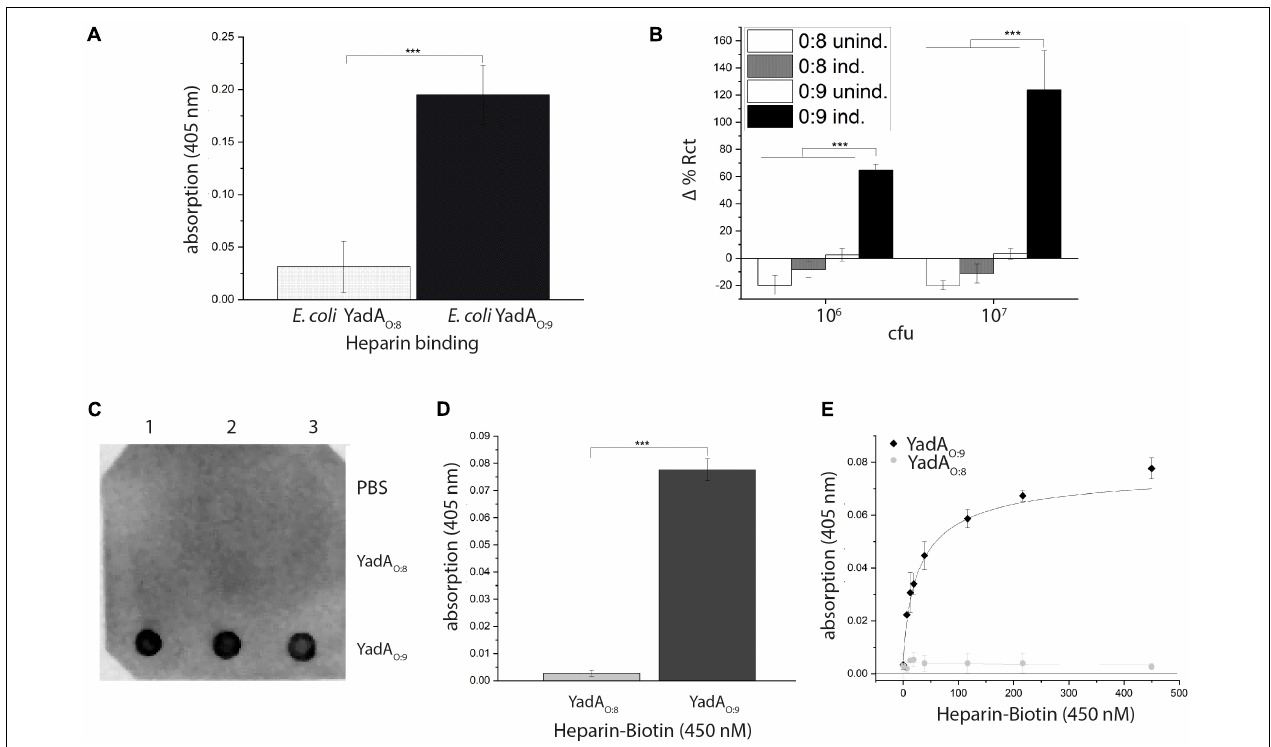
FIGURE 5 | YadA O : 9 directly binds to heparin. (A) Whole-cell binding assay of heparin to E. coli expressing YadA O : 8 or YadA O : 9 shows binding of YadA O : 9 -expressing bacterial binding to heparin. (B) Impedimetric biosensor experiment showing the adhesion of bacteria expressing YadA O : 8 or YadA O : 9 to surface-coated heparin. (C) Dot blot using immobilized YadA O : 8 or YadA O : 9 head domains shows direct binding to biotinylated heparin. (D) ELISA-like binding assay using immobilized YadA head domains to capture biotinylated heparin. (E) ELISA-like binding assay showing the interaction between immobilized, purified YadA head domains and biotinylated heparin in a concentration-dependent manner. Significance levels are indicated with * p < 0.05, ** p < 0.01, *** p <